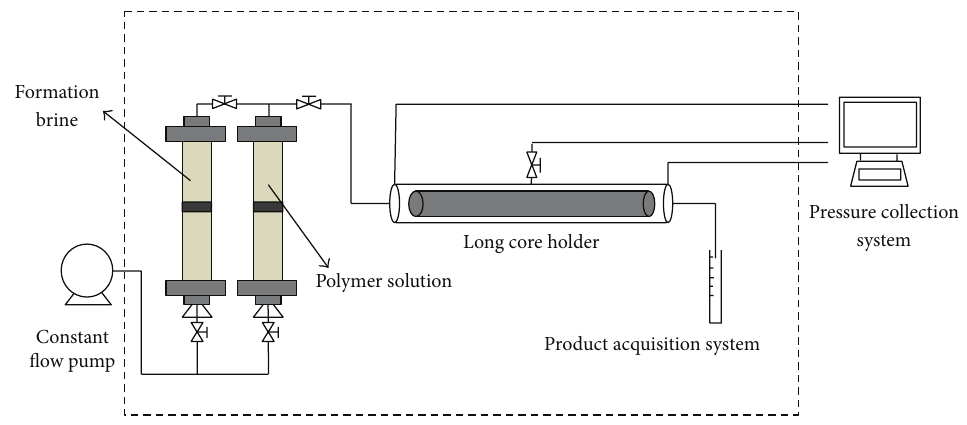
Figure 1: Flow chart of injection